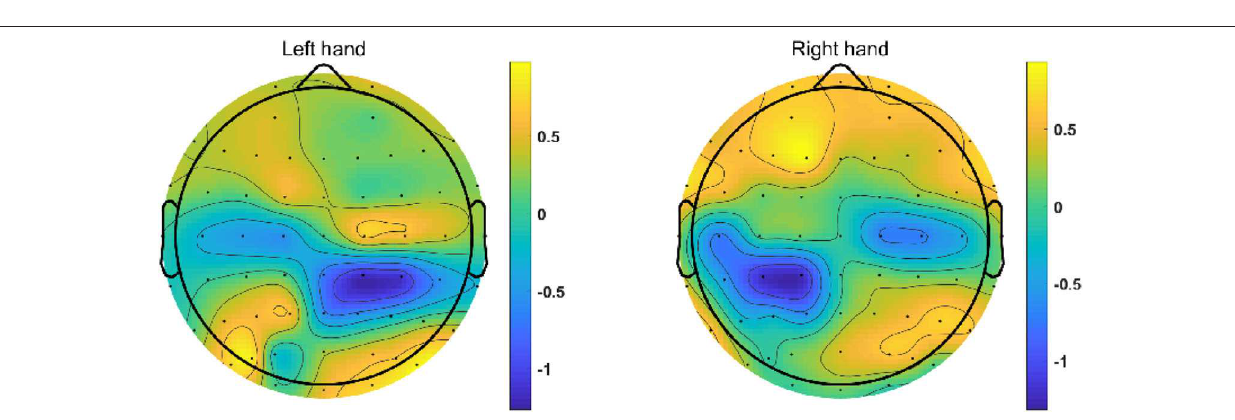
Frontiers in Human Neuroscience |